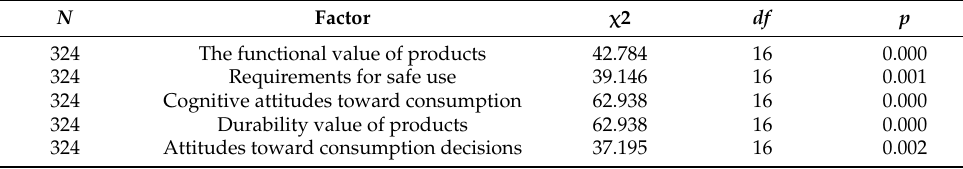
Table 10. Abstract of the Chi-square tests on the dimensions and consumers’ age. N